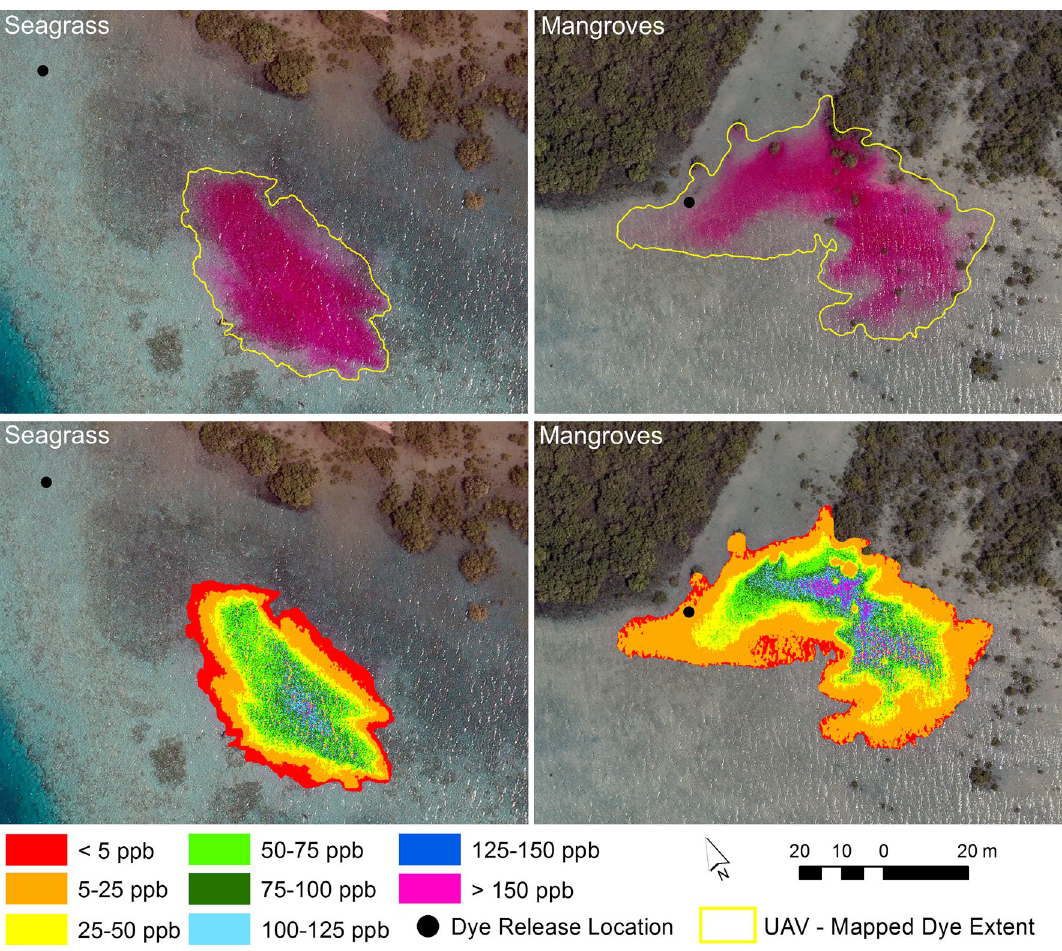
Figure 6. Maps of dye plume extent and corresponding concentrations. Maps of dye plume extent produced from object-based image analysis and maps of dye concentration based on an interaction term of band indices derived from unmanned aerial vehicle data collected at 11:10 and 11:18 for the seagrass and mangrove release sites, respectively. Software used to produce the maps: eCognition Developer version 10.1.1 (https:// geosp atial. trimb le. com/ produ cts- and- solut ions/ ecogn ition) and ArcGIS version 10.5.1 (www. esri. com/ en- us/